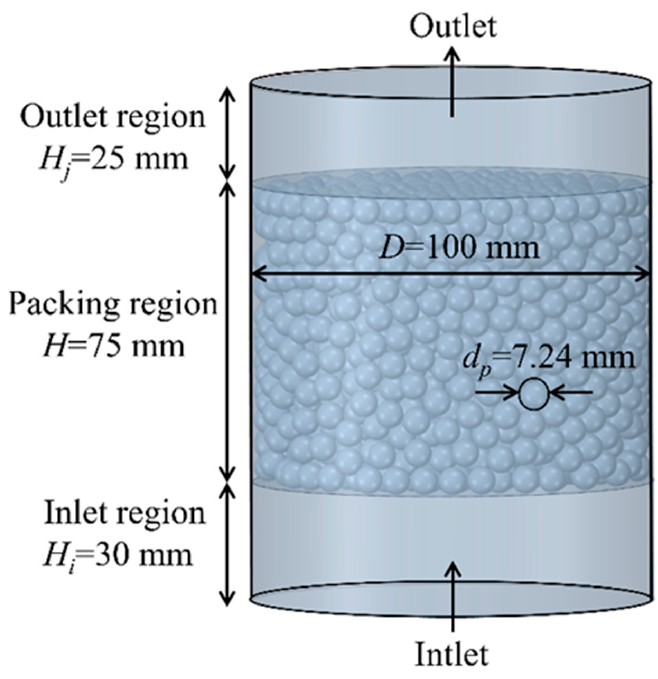
Figure 2. Soybean packing geometry model diagram.